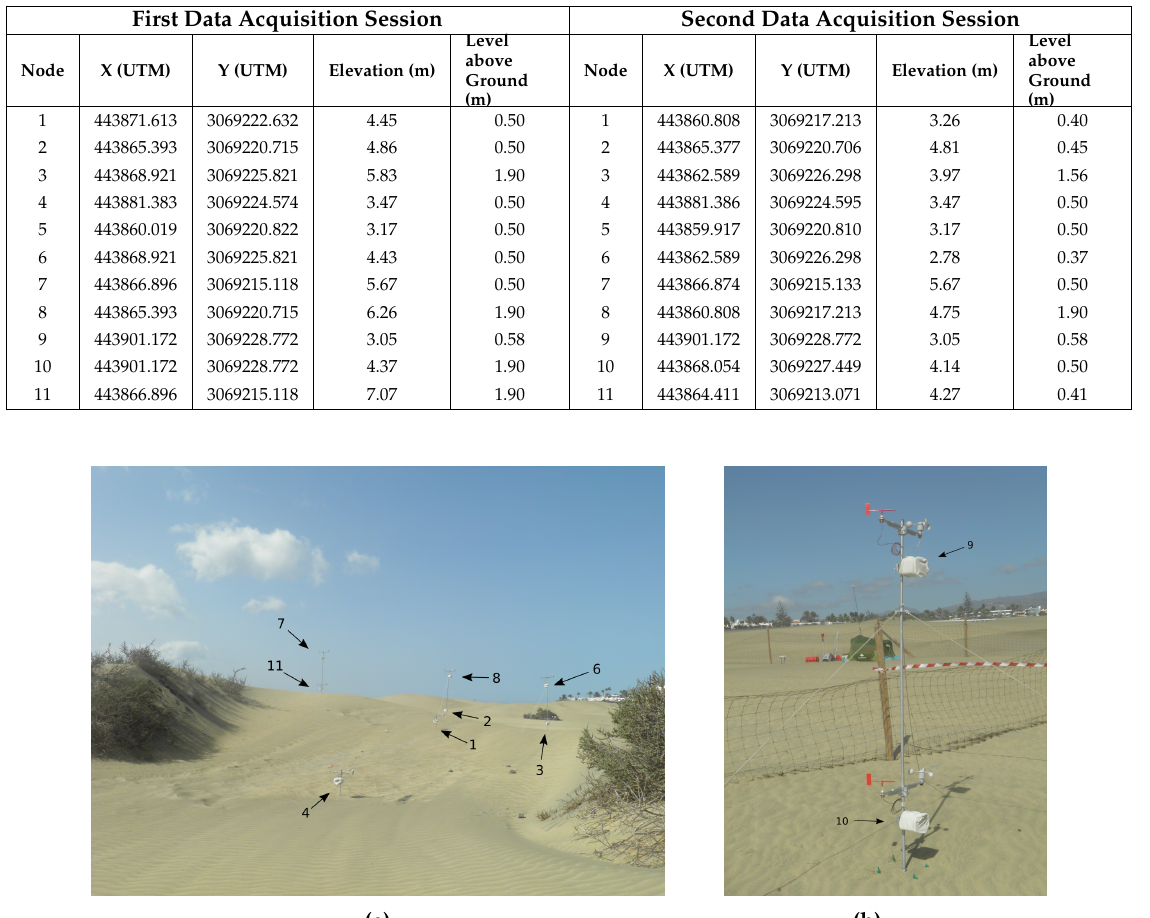
Table 2. Data acquisition sessions. Location and elevation of sensor nodes.